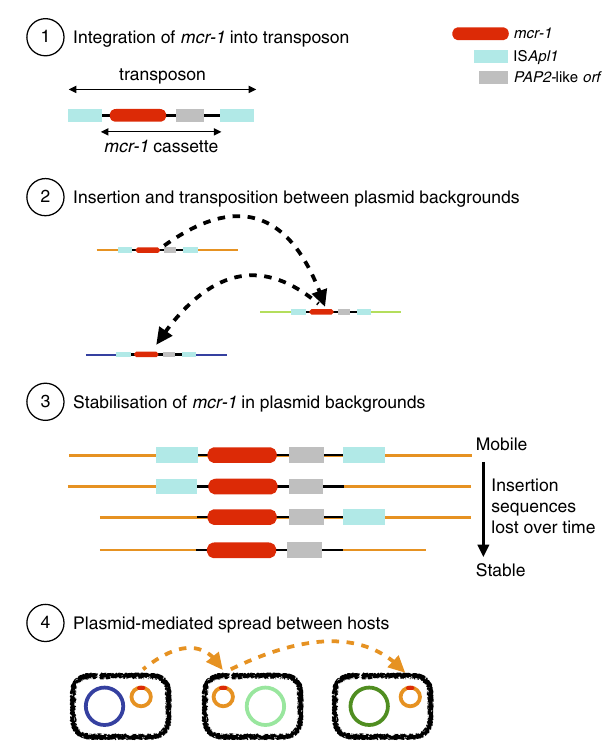
Fig. 2 Schematic representation of the evolutionary model for the steps in the spread of the mcr-1 gene. (1) The formation of the original composite transposon, followed by (2) transposition between plasmid backgrounds and (3) stabilization via loss of IS Apl1 elements before (4) plasmid- mediated